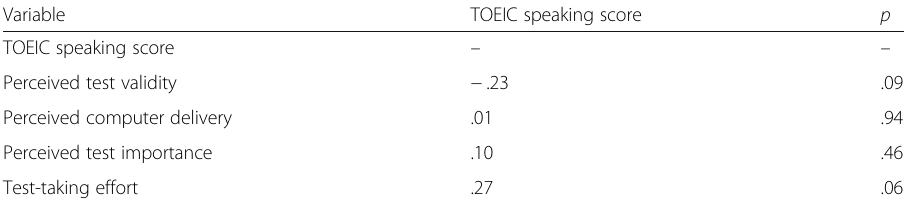
Table 4 Semi-partial correlations between TOEIC Speaking score and other variables Variable TOEIC speaking score